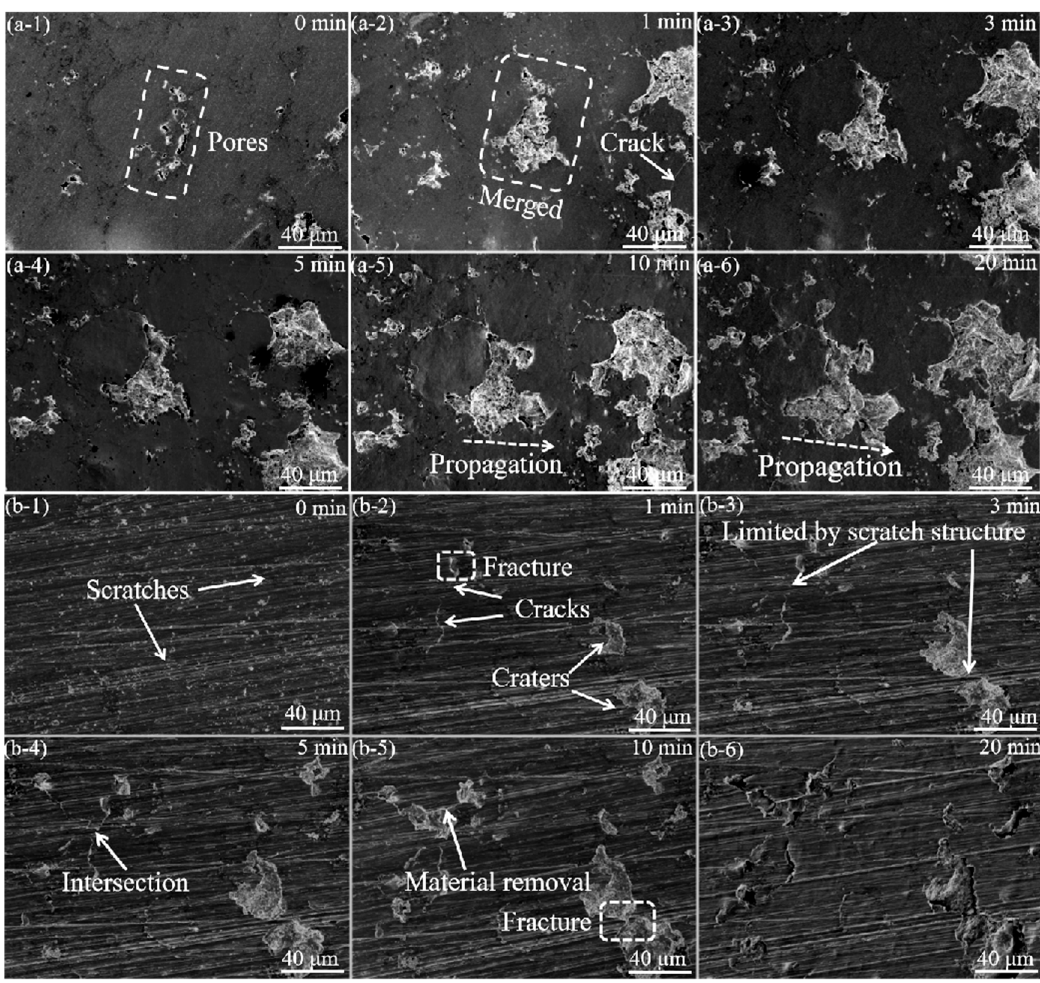
Figure 7. The microstructural evolution of the coating ( a ) and ground coating ( b ) specimens during the cavitation erosion process for ( -1 ) 0 min, ( -2 ) 1 min, ( -3 ) 3 min, ( -4 ) 5 min, ( -5 ) 10 min, and ( -6 ) 20 min.